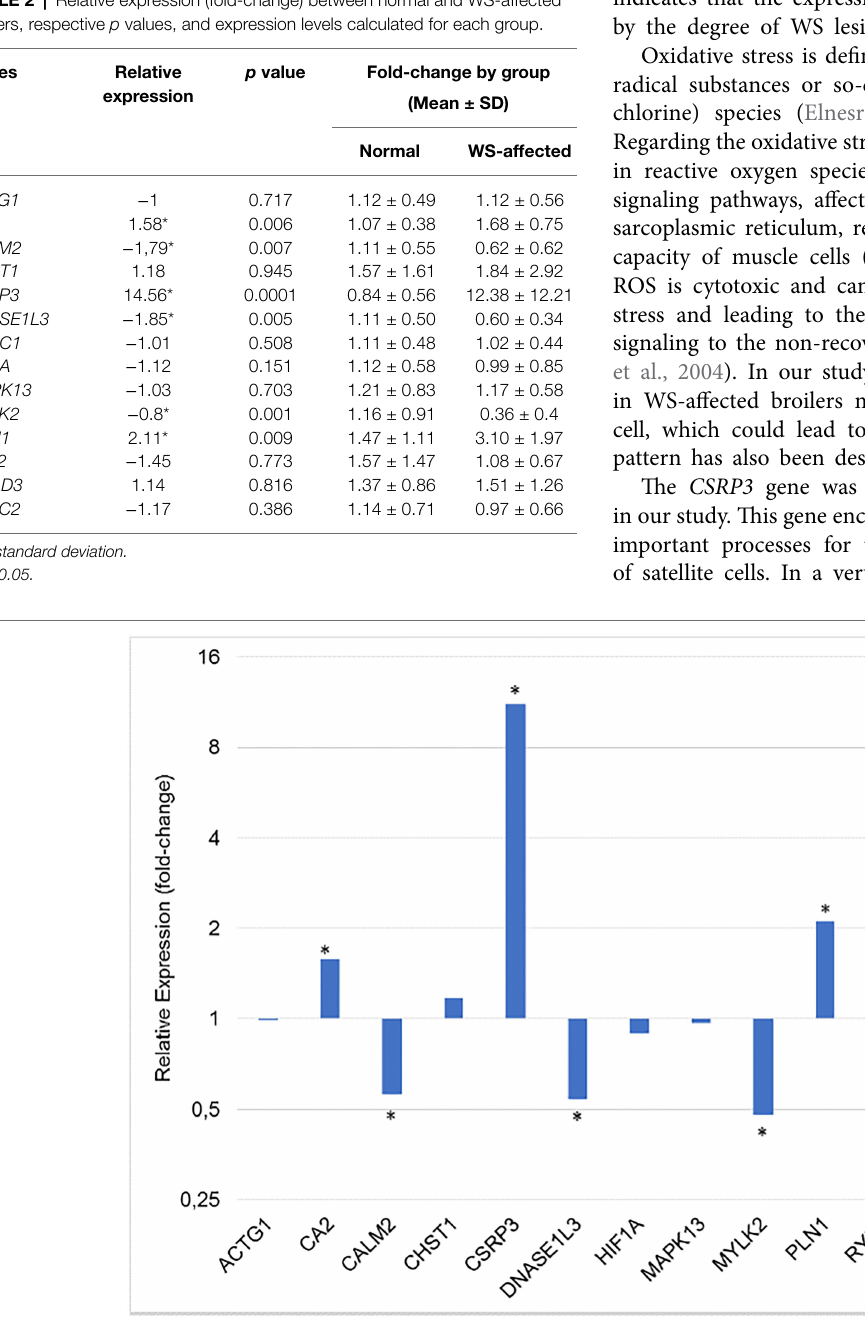
FIGURE 1 | Gene expression ratio between normal and WS-affected broilers at 42 days of age, normalized for RPL30 and RPL5 reference genes. * p <